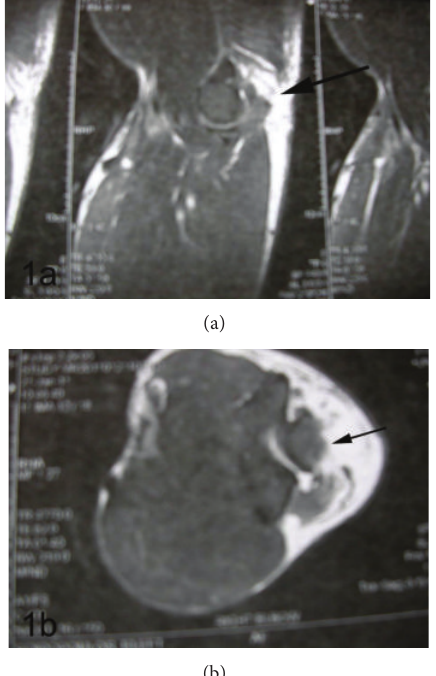
Figure 1: Preoperative MRI (scanned from hard copy) with arrows indicating the complete distal triceps tendon rupture at its insertion at the olecranon in a sagittal (a) and transverse (b) view.